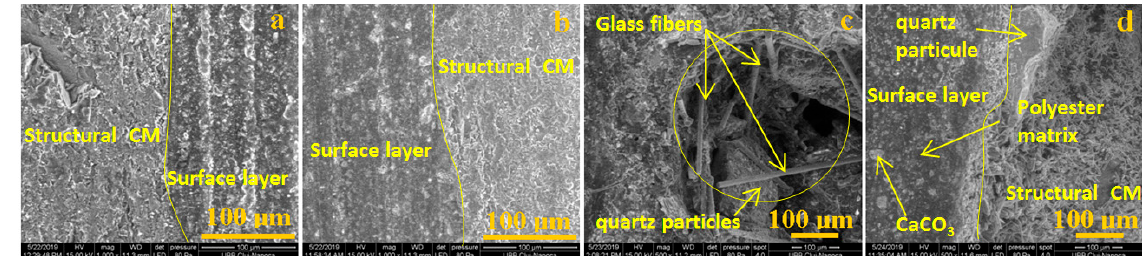
Figure 6. SEM images at the CM interface: ( a ) control group; ( b ) exposed to rainwater; ( c ) exposed to acetic acid; ( d ) exposed to sulfuric and nitric acid.